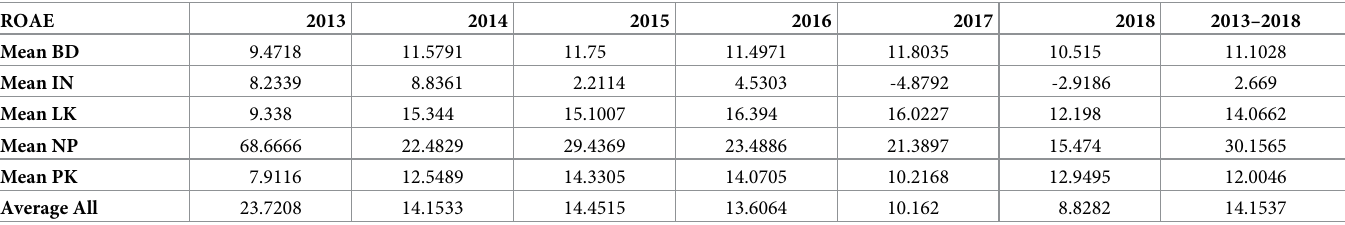
Table 1. Average of returns on equity (AROE) of 147 SA